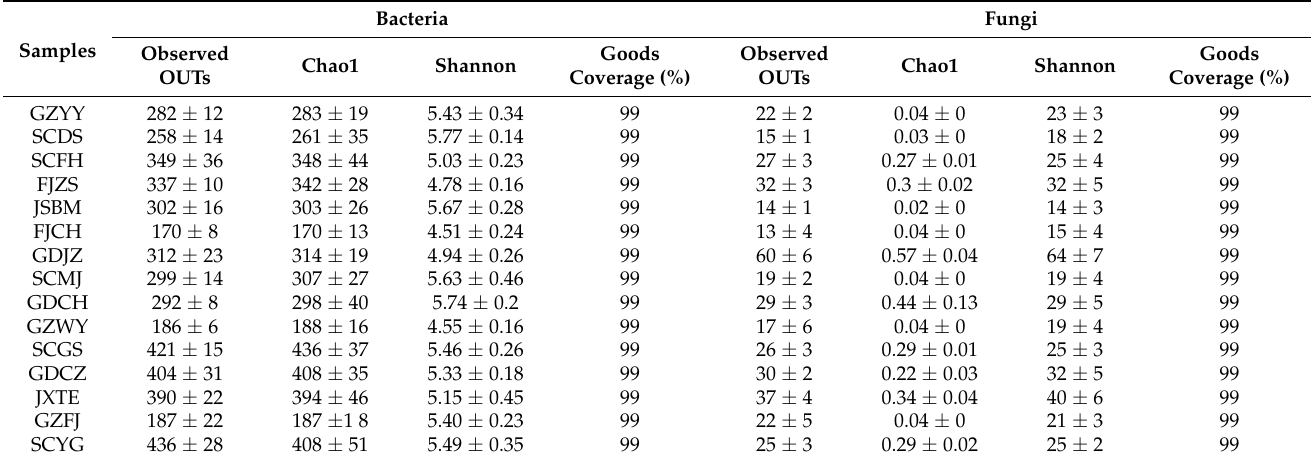
Table 4. Alpha diversity metrics of microbial community in FM